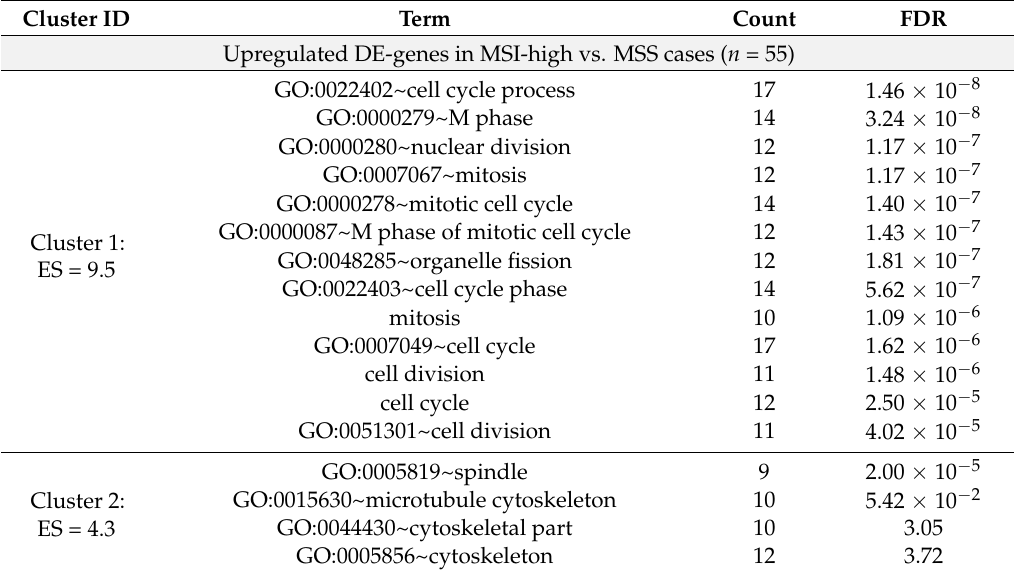
Table 3. Functional annotation clustering results for DE-genes separated according to the expression profile in MSS vs. MSI-high cases. Three clusters of associated biological terms were detected for upregulated DE-genes, while only one was detected for downregulated DE-genes. Notice that some terms among clusters are not significantly enriched (FDR >